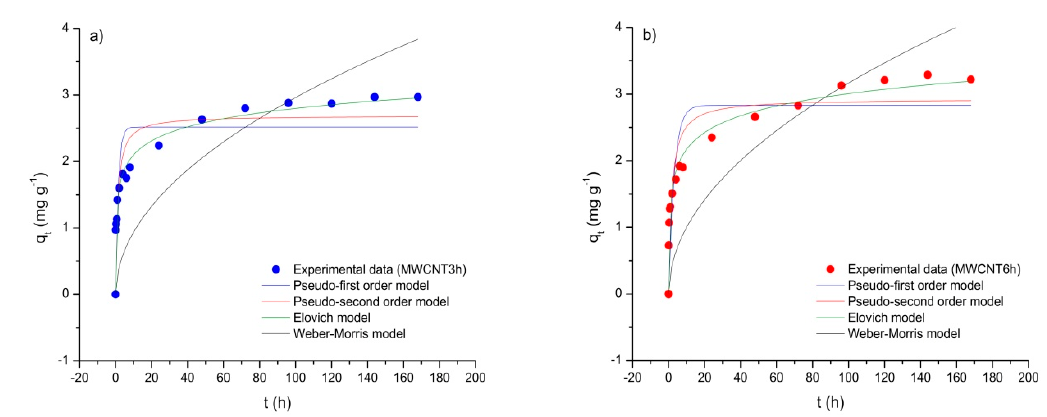
Figure 4. Non-linear regressions of kinetics data, obtained using Lagergren pseudo-first order, pseudo-second order, Elovich and intra-particle diffusion models for Cr(VI) adsorption on ( a ) oxMWCNT3h and ( b ) oxMWCNT6h. Table 4. Parameters of Lagergren pseudo-first order, pseudo-second order, Elovich and intra-particle diffusion models for the adsorption of Cr(VI) on oxMWCNT3h and oxMWCNT6h.